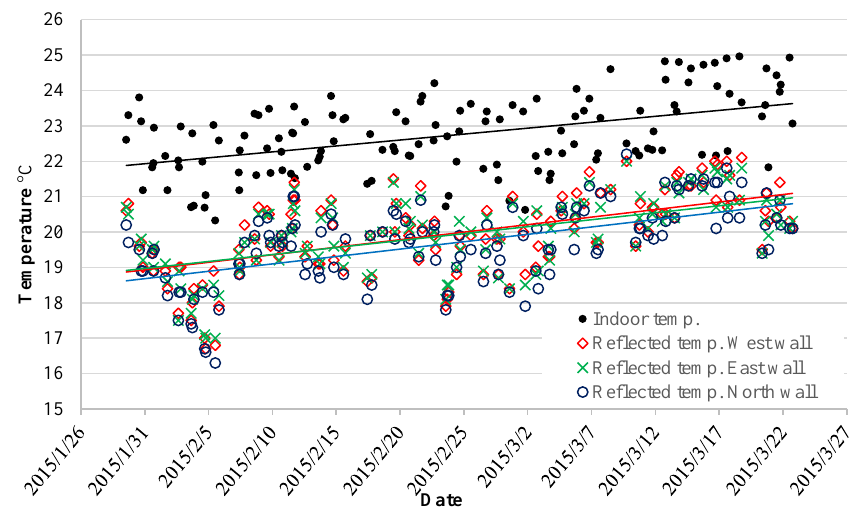
Figure A3. The indoor temperature and the reflected temperature measured on the three walls during the three measurement periods with 15 min sampling interval between measurements.